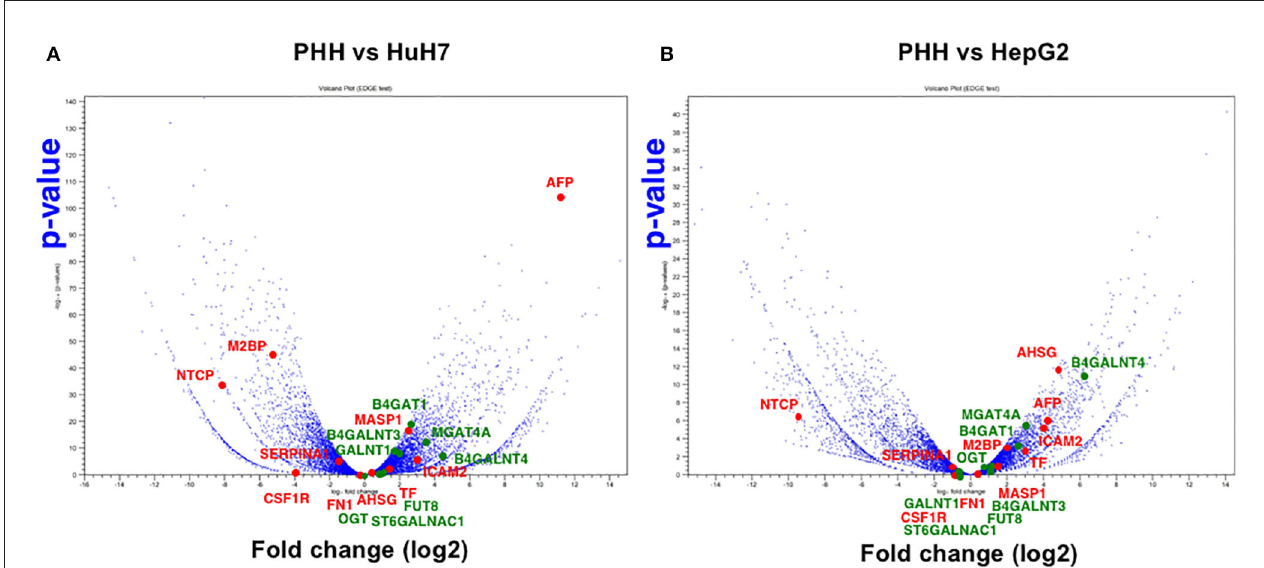
FIGURE 3 | Volcano plot analysis to find differentially expressed genes in hepatic cells. Differentially expressed genes between PHH and HCC cells ( A : PHH vs. HuH7, B : PHH vs. HepG2) were extracted from RNA-Seq data and the genes are plotted on significance vs. fold-change on the y- and x-axes, respectively. The y value indicates − log10 of the p -value obtained from the Empirical analysis of DGE. Candidates for glyco-biomarker identified in previous reports (red, 8, 29, Table 1 ) and glycogenes (green) are indicated as examples.